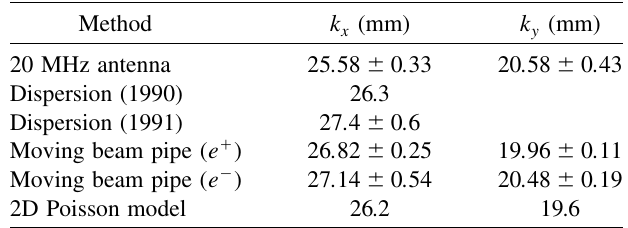
TABLE I. Measured scale factors for CESR arc BPMs.